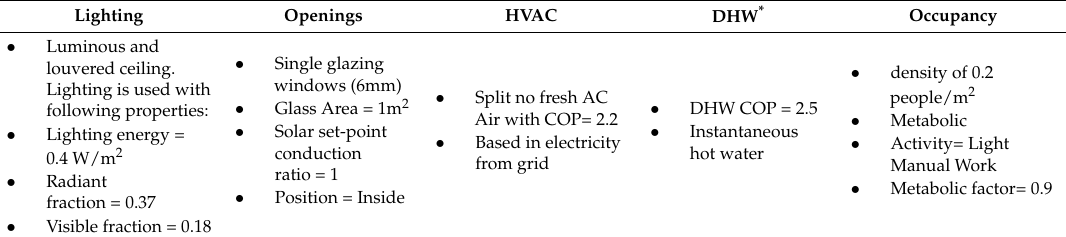
Table 1. Summary of the input data for simulation in